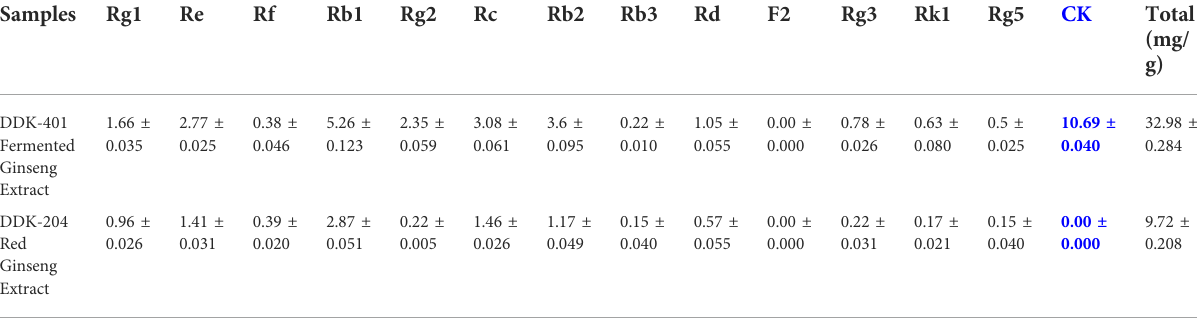
TABLE 2 Ginsenoside pro fi les of DDK-401 and DDK-204 for in vivo pharmacokinetic assessments.